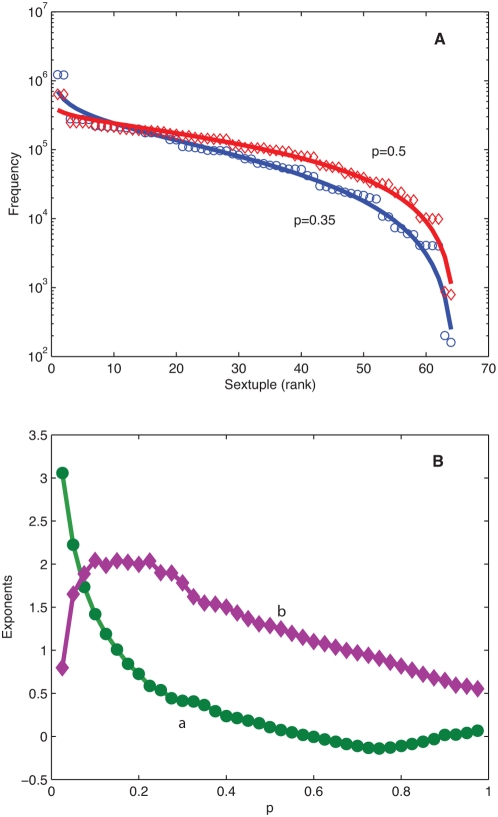
Frequency-rank distributions of sextuples generated by an expansion-modification algorithm.(A) Data is generated by the algorithm described in the text. Circles are determined with a modification probability p = 0.35, the corresponding solid line is the DGDB fit with (a,b,R2) = (0.36,1.55,0.96). For the rhomboids p = 0.5 and (a,b,R2) = (0.11,1.28,0.96). (B) shows the variation of the parameters (a,b) with probability p.